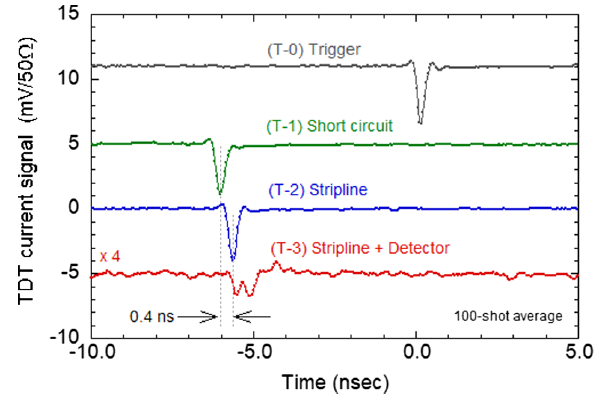
FIG. 6. Time structure of TDR